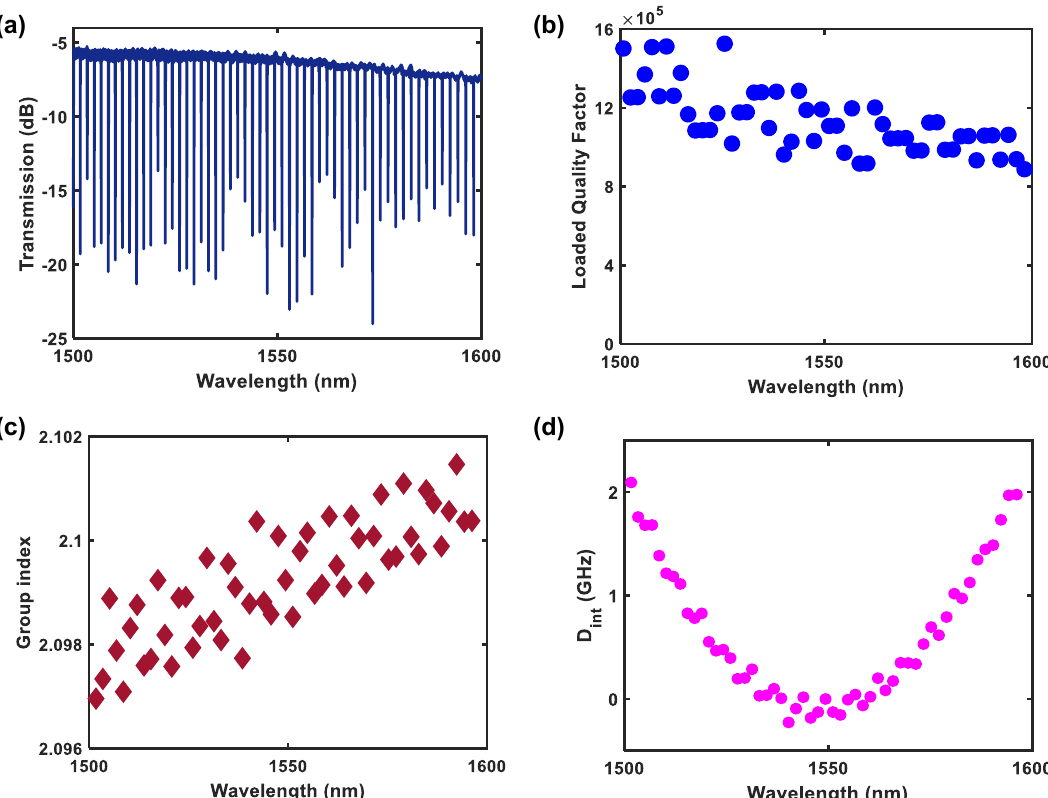
Figure 2: Silicon nitride microresonator optical properties. Experimentally measured (a) transmission spectrum, (b) quality factor and (c) group index of the microresonator. (d) The extracted dispersion, D